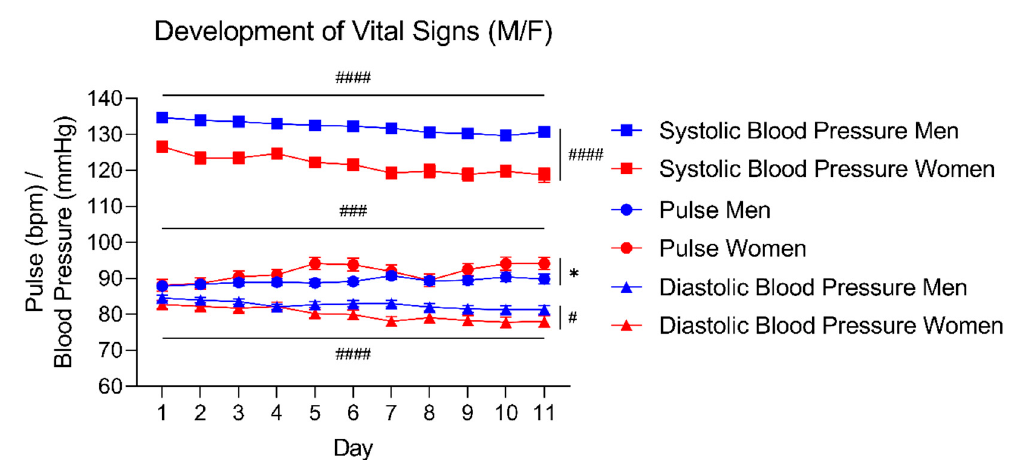
Figure A1. Development of vital signs over time in males and females during the first 11 days of GHB tapering. Data presented as mean ± SEM. Error bars are not shown if they are shorter than the size of the symbol. # = main effect of sex, p < 0.05; ### = main effect of time, p < 0.001; #### = main effect of time/sex, p < 0.0001; * = time × sex interaction, p < 0.05. Table A1. Correlation between similar withdrawal symptoms measured with both the subjective- and objective withdrawal scale.